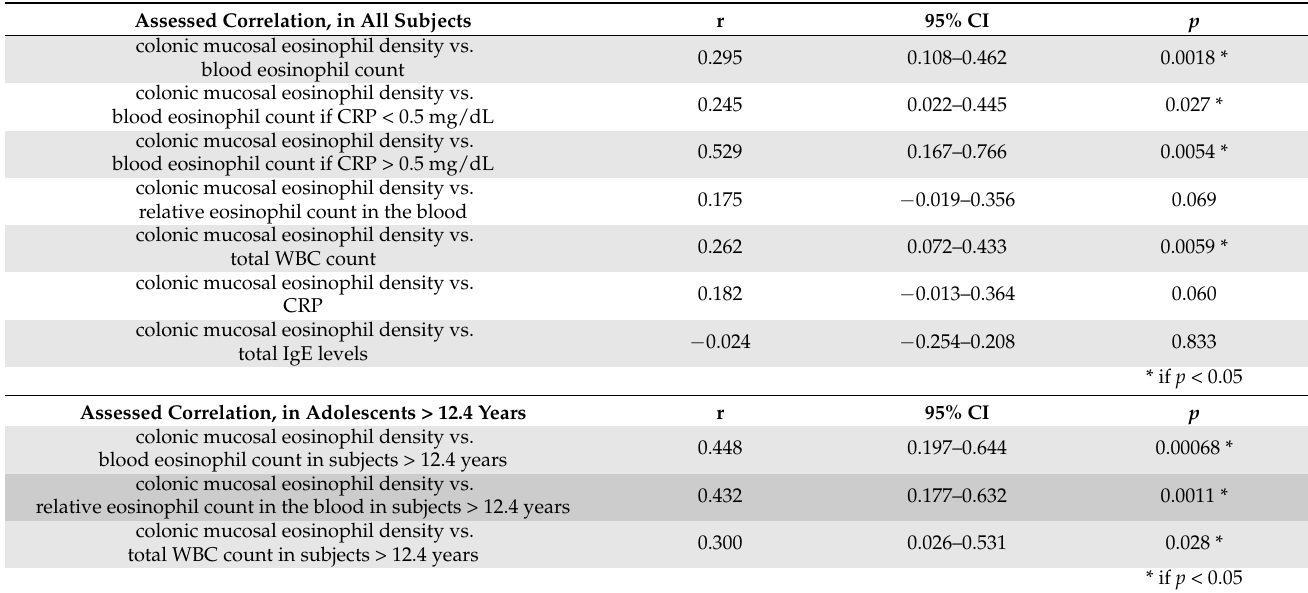
Table 2. Correlations between colonic mucosal eosinophil density and other parameters in all the subjects and in selected subgroups. Spearman’s rho (r) is presented, along with 95% confidence intervals (95% CI). p values < 0.05 are indicated with asterisk